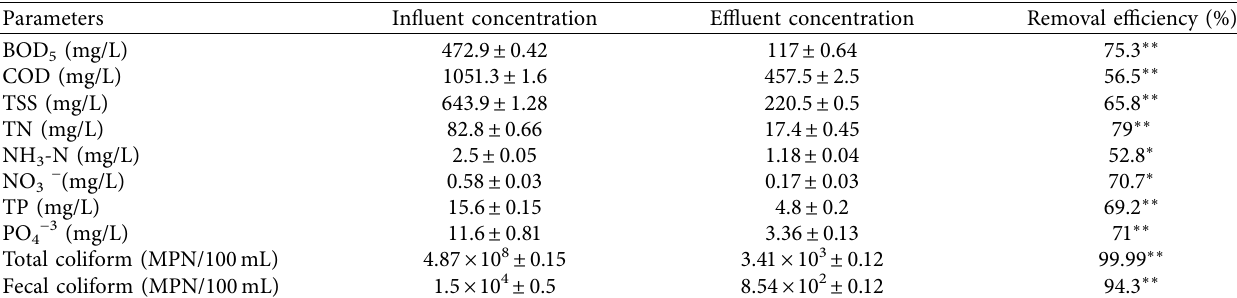
Table 3: Mean ± SD physicochemical and bacteriological quality analysis of WSP system in Kito Furdisa Campus, Jimma University, Jimma town, Southwest Ethiopia, 2020.